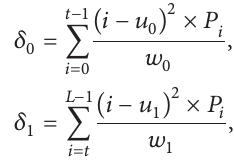
where 𝑤 0 , 𝑤 1 , 𝑢 0 , and 𝑢 1 are the same as given in (9),